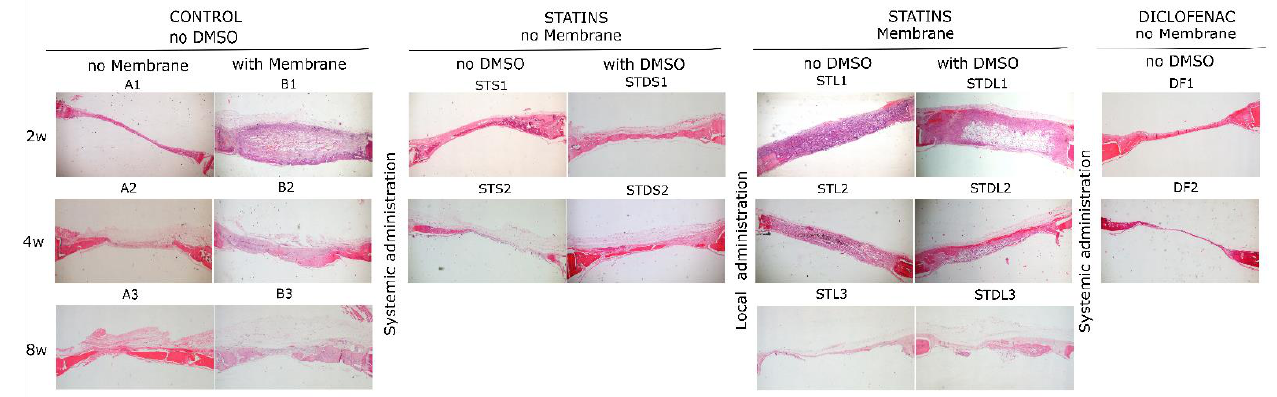
Figure 4. Histological micrographs of all of the groups showing the degree of new bone formation in the created bone defect for all of the subgroups. Magnification x20.